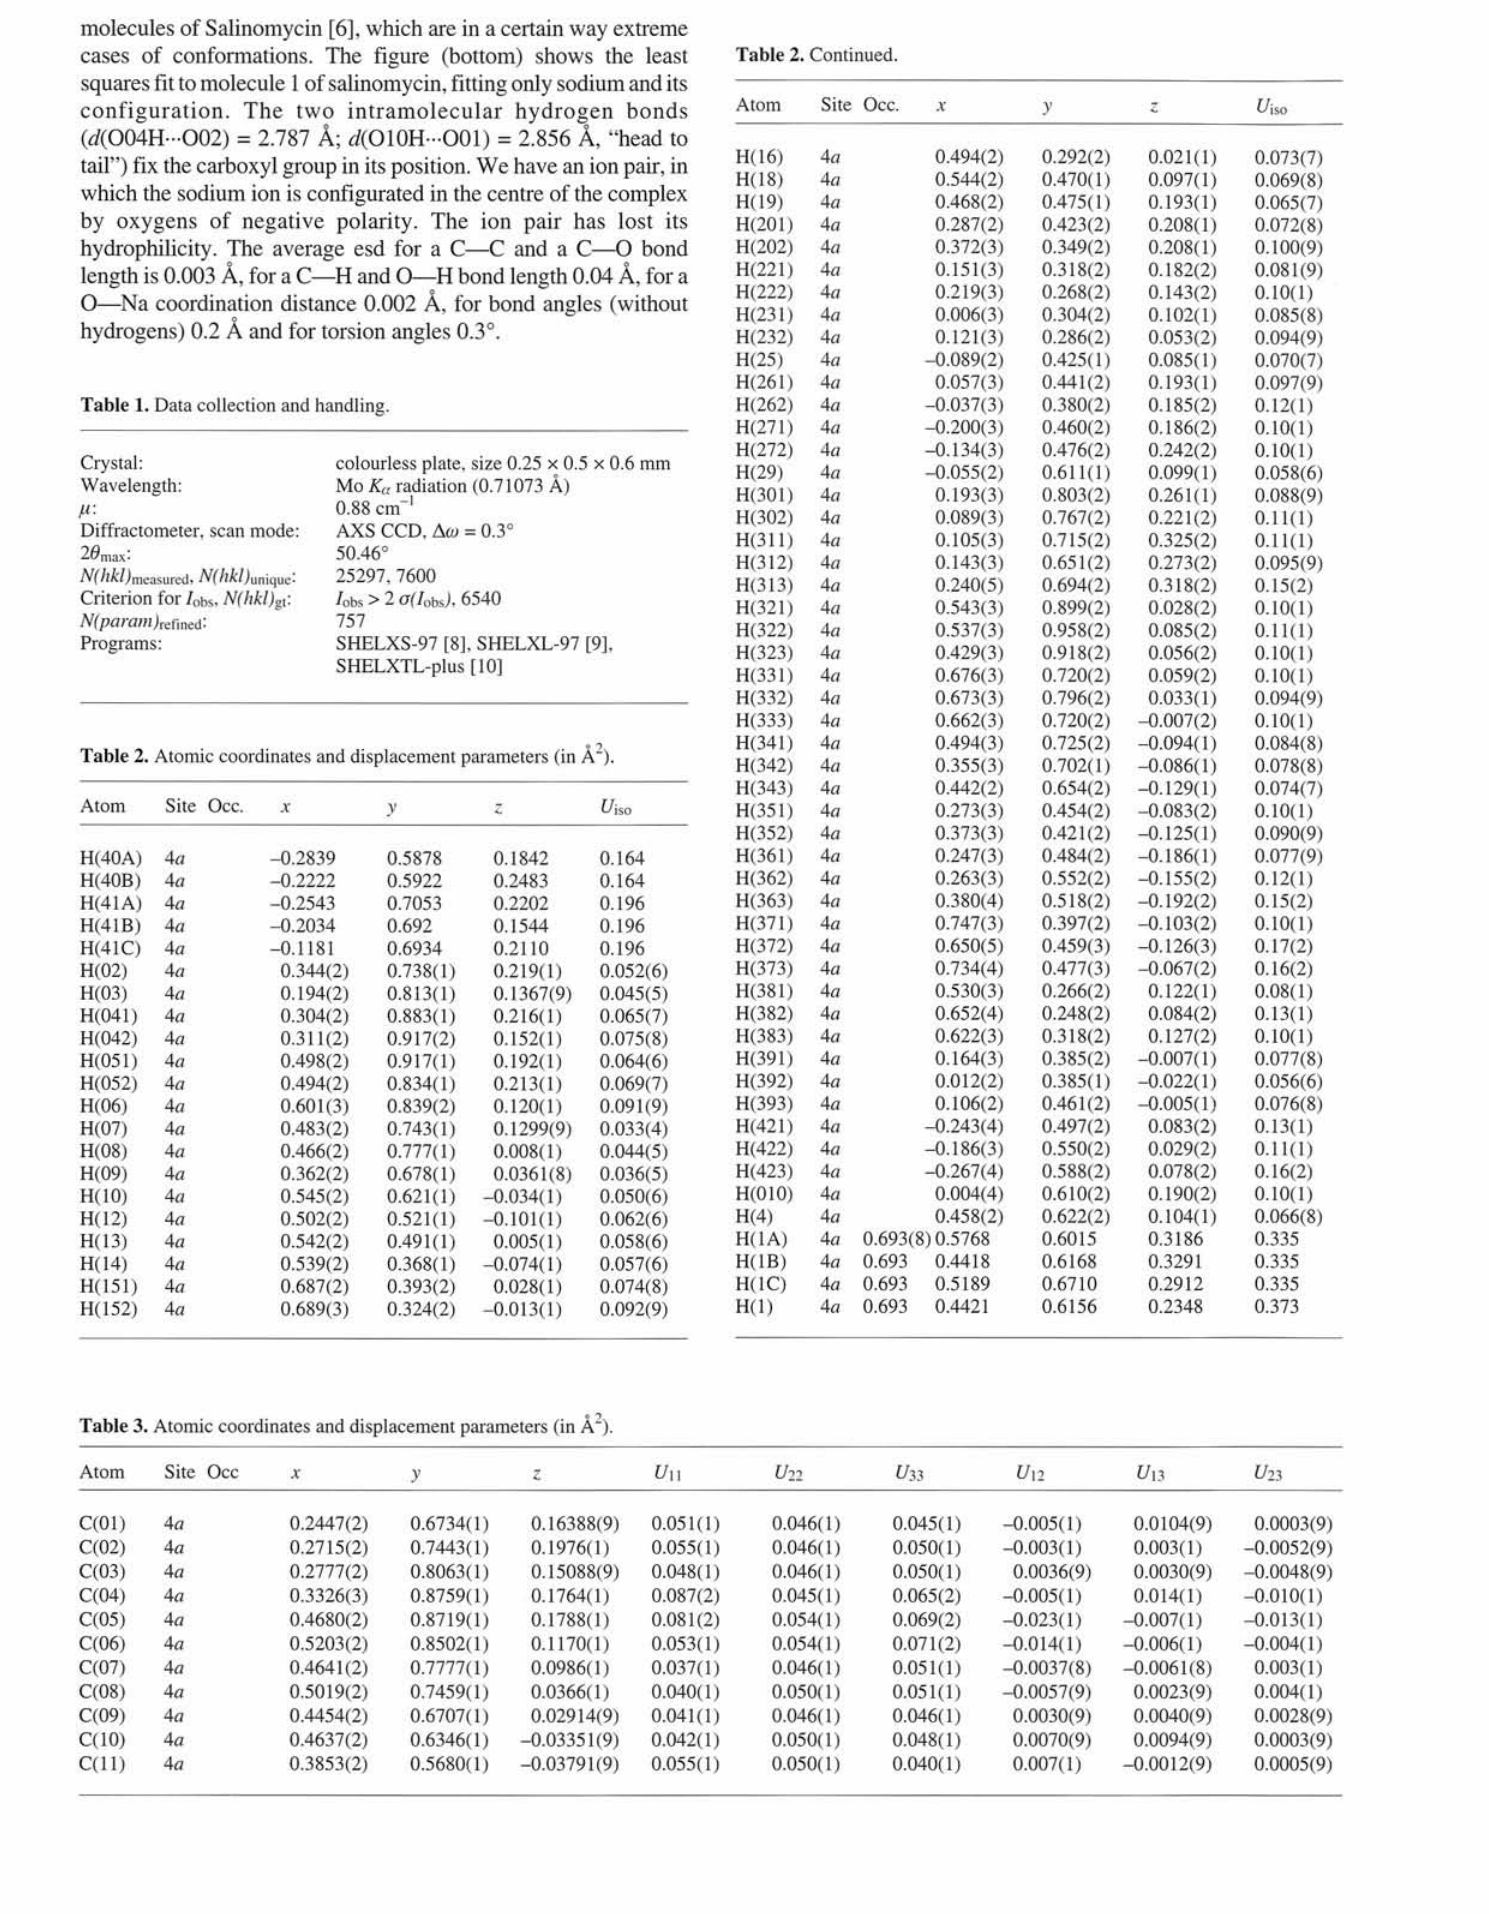
Table 3. Atomic coordinates and displacement parameters (in Â 2